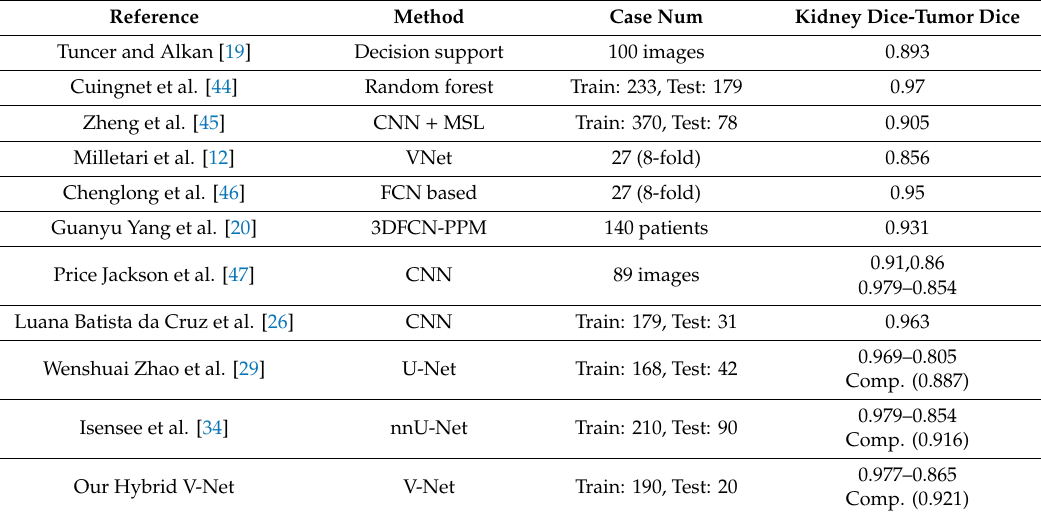
Table 3. Comparison of kidney and tumor segmentation methods for Computed Tomography (CT) images.